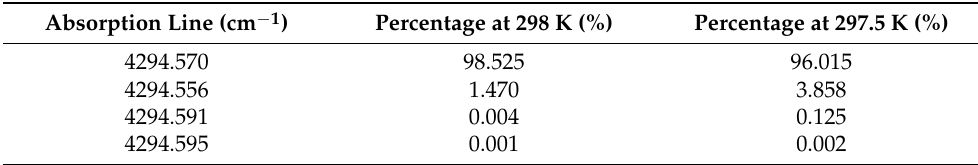
Figure 1. Overlapping absorption lines at 4294.570 cm − 1 used in the experiment and temperature measurement absorption line. Table 1. The effect of interference absorption lines at 297.5 K and 298